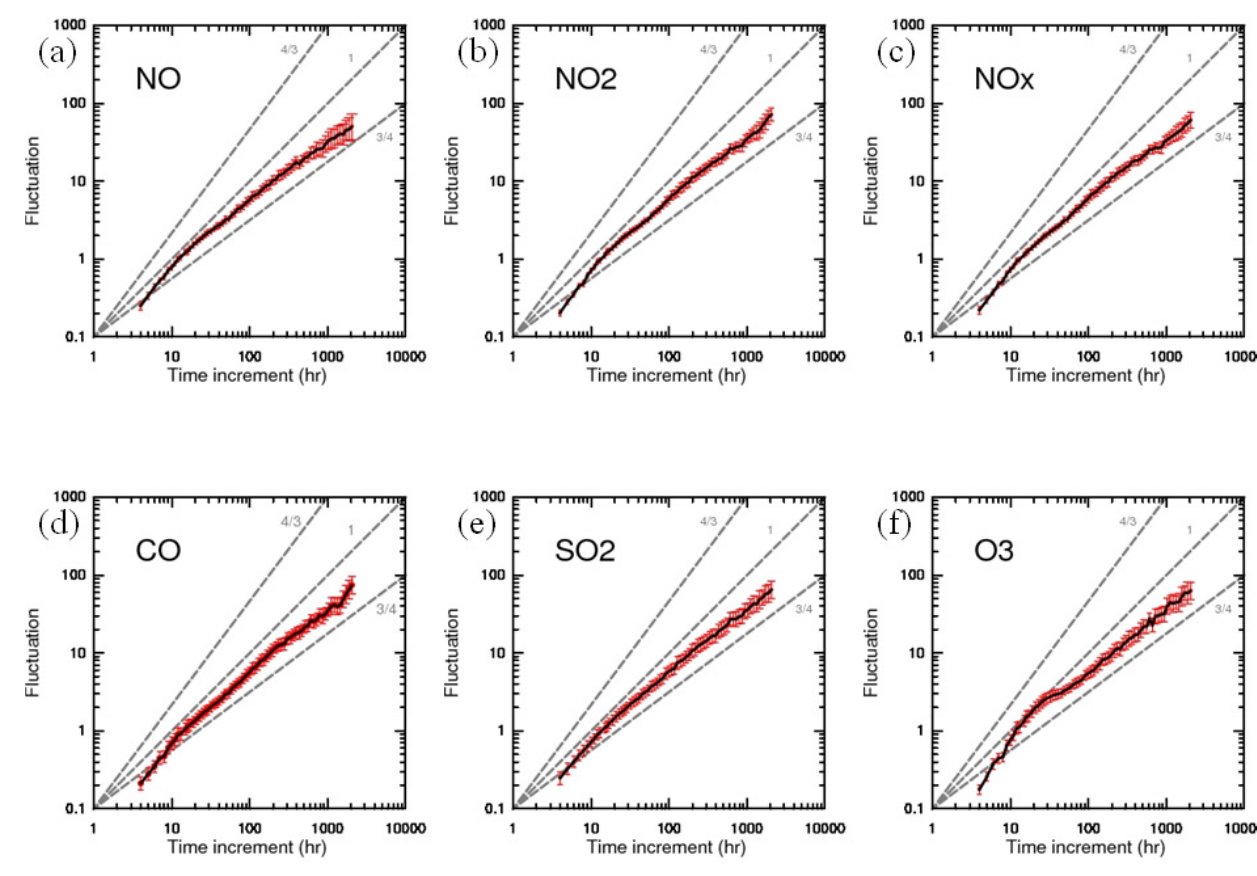
Fig. 4. The DFA spectra (in log-log scale) of the gases, NO (panel a ), NO 2 (panel b ), NO x (panel c ), CO (panel d ), SO 2 (panel e ), and O 3 (panel f ). The black curves are the 74-station averages, and the red bars are standard deviations from the averages. The grey dash lines indicate the power-law scaling of 4/3, 1 and